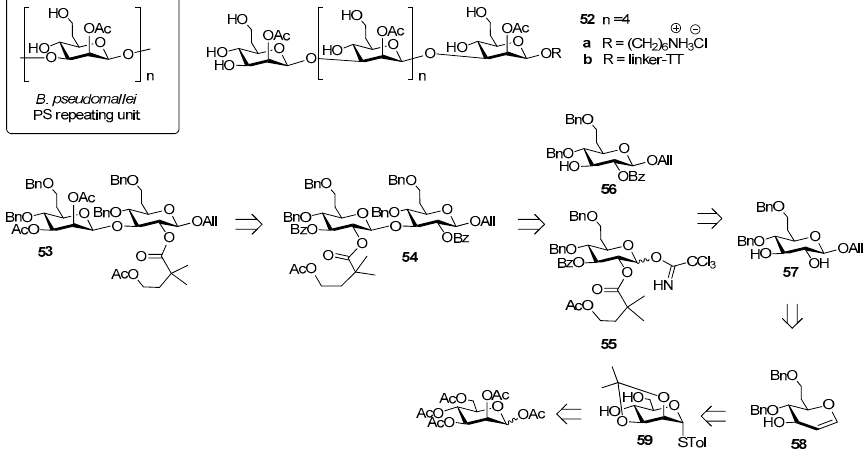
Figure 6. B. pseudomallei CPS repeating unit and retrosynthetic analysis of compound 52 reported in [37].